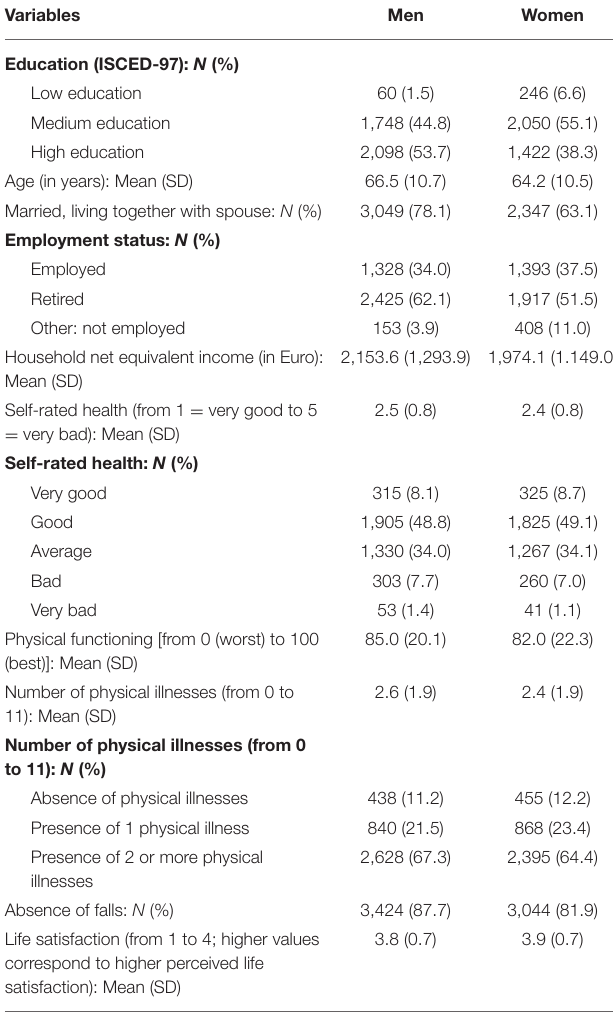
TABLE 1 | Sample characteristics for individuals stratified by sex (men: n = 3,906 observations; women: n = 3,718 observations) included in linear fixed effects regressions (wave 5 to wave 6,